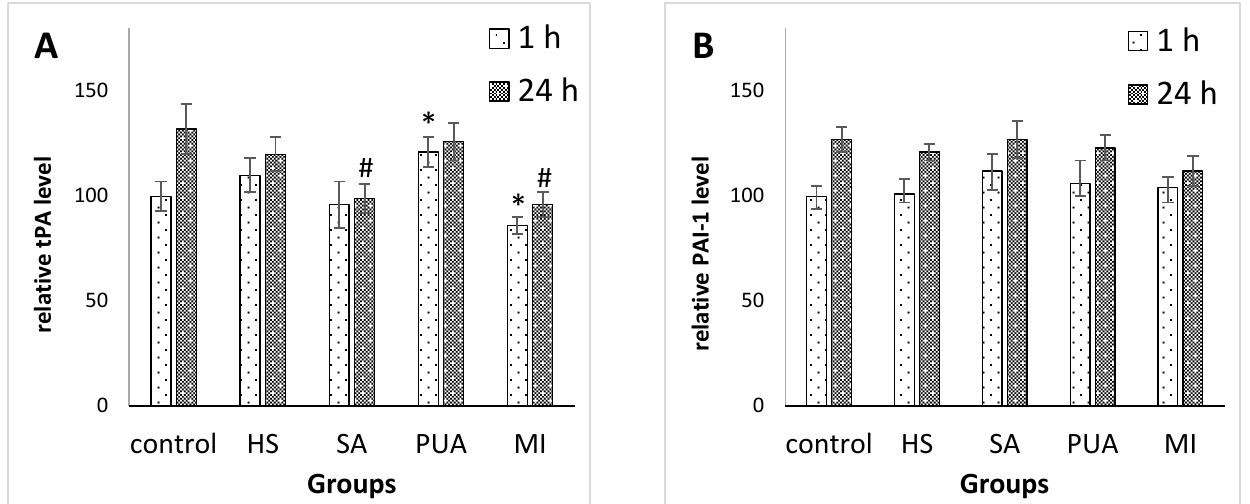
Figure 1. The relative levels of tPA ( A ) and PAI-1 ( B ) detected in HEPC culture incubated with peptide fraction isolated from plasma of healthy subjects (HS), patients with stable angina (SA), progressive unstable angina (PUA), or myocardial infarction (MI). The levels of both tPA and PAI-1 in culture treated with buffer instead of peptide solution (control) after 1 h incubation period were set at 100%, and all data shown represent percentage relative to control at 1 h time point. * p < 0.05 compared with control at time point 1 h; # p < 0.05 compared with control at time point 24 h.